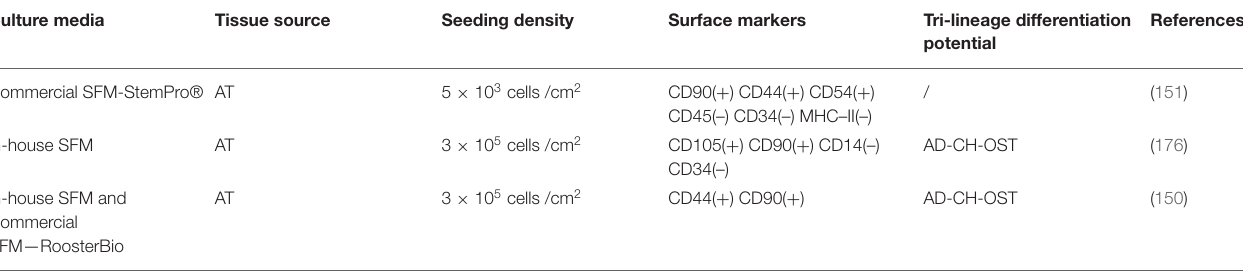
TABLE 4 | Characterization of canine mesenchymal stromal cells cultured in serum-free media.